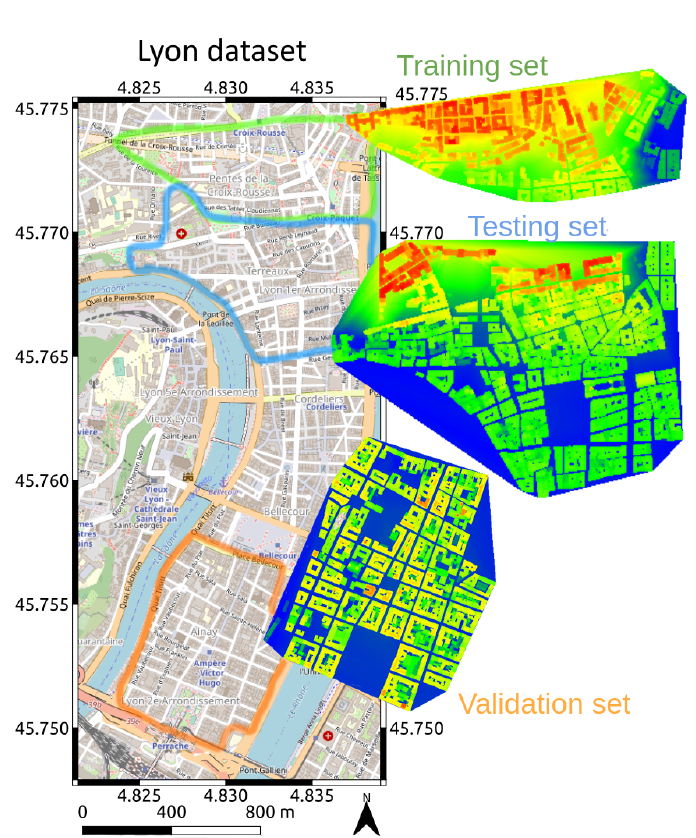
Figure 4. Lyon dataset split into 3 distinct parts: training, validation and test sets. Elevation is shown in color and is relative to each